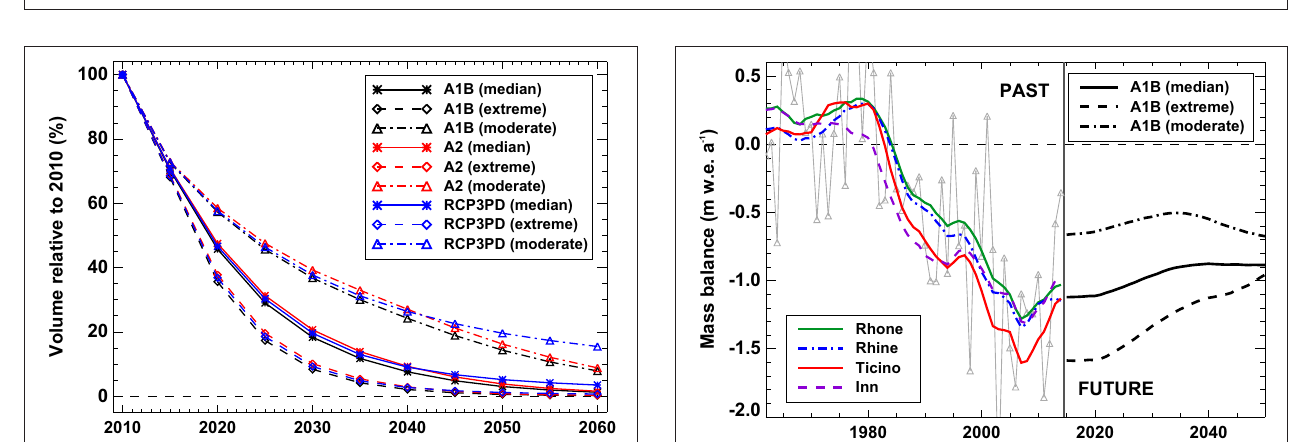
FIGURE 7 | Calculated future evolution of St. Annafirn (Figure 3) according to the A1B median scenario. (A) A longitudinal and a transversal cross-section are shown, and (B) ice-covered areas are visualized in pentadal steps.